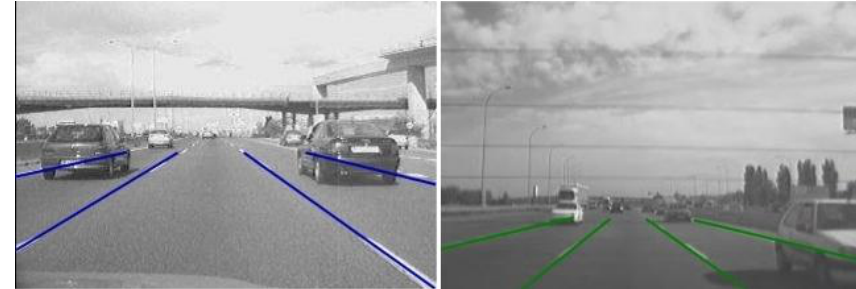
Figure 3. Vehicle searching area as a result of the lane markings analysis for forward and rear